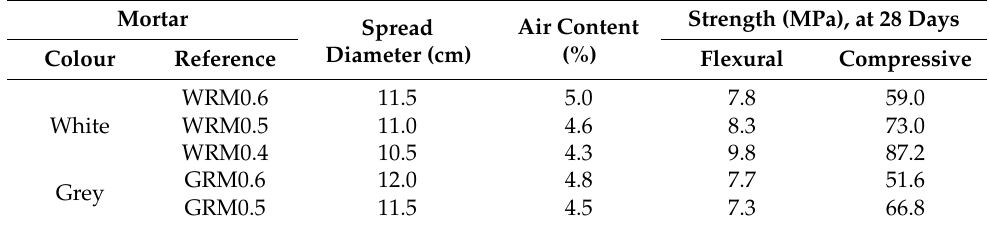
Table 3. Characterisation properties of reference mortar.